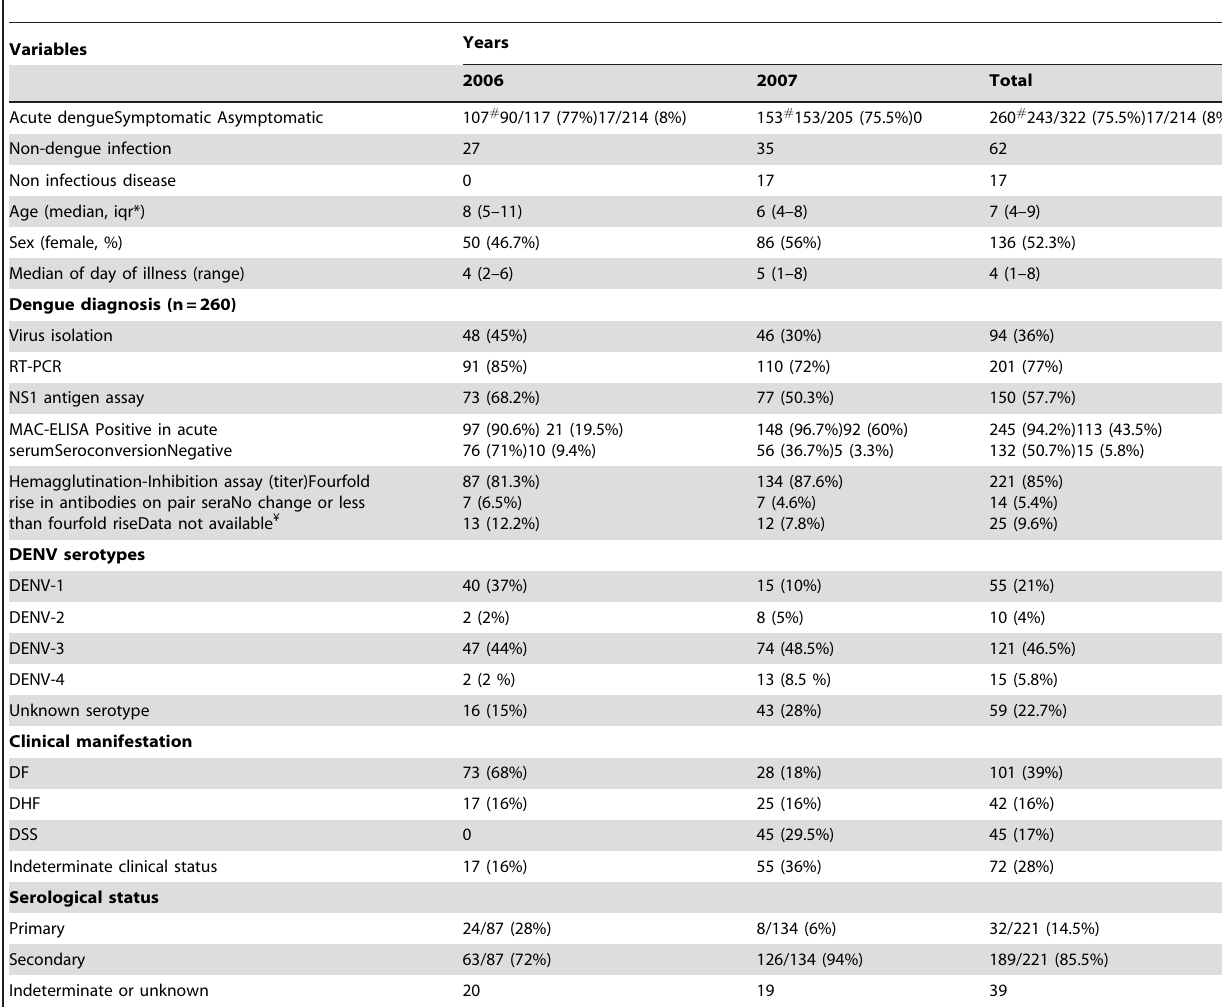
Table 1. Summary of demographic, clinical and virological information of studied